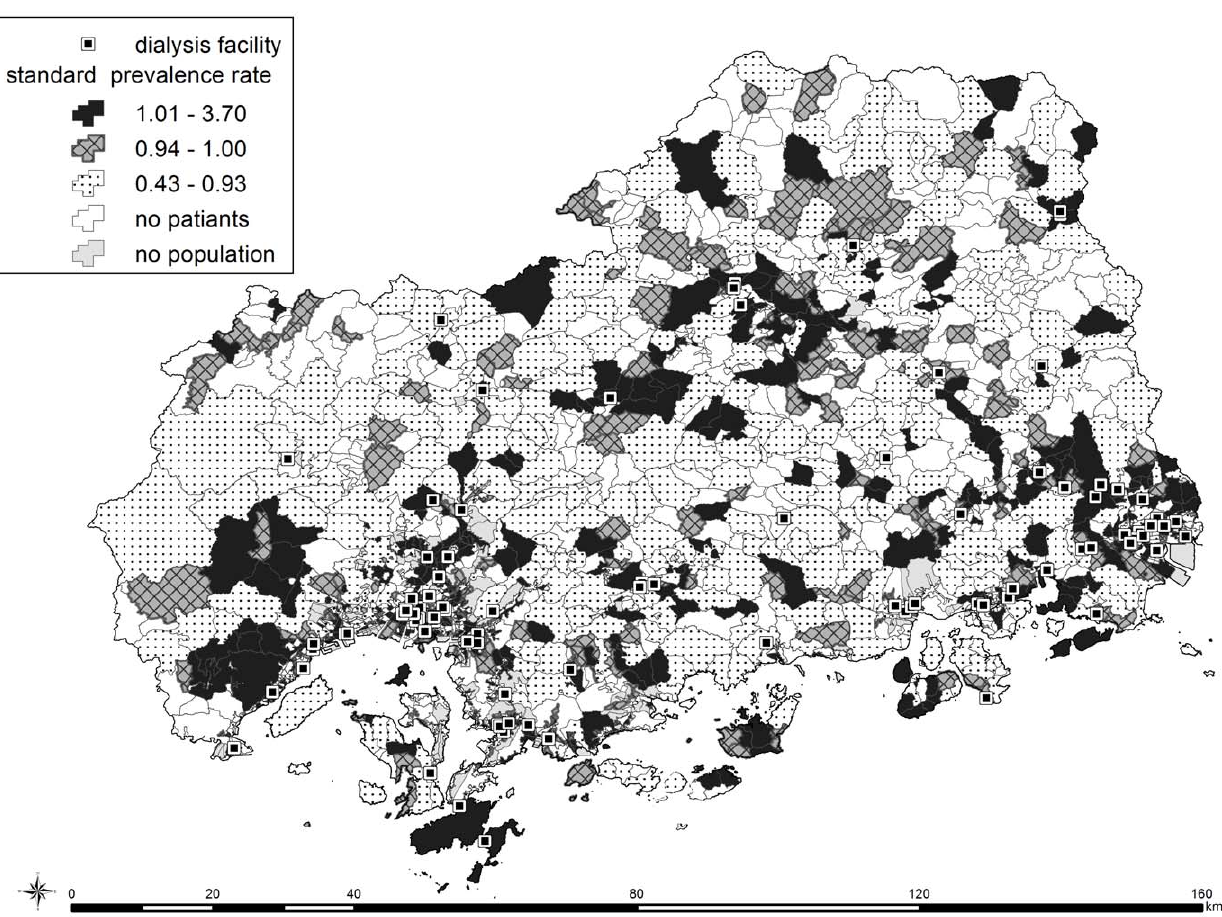
Figure 3. Empirical Bayesian estimate of age- and sex-adjusted standard prevalence rates (SPRs) of dialysis patients at each census block.